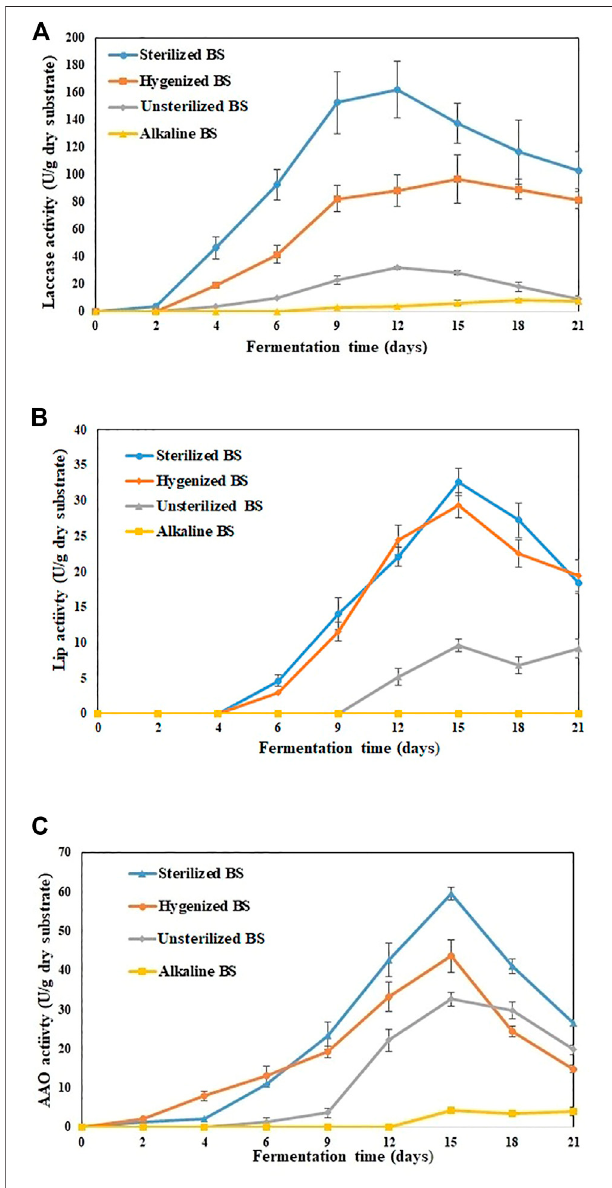
FIGURE 1 | Extracellular enzyme activities detected in various treated BS during 21 days of fermentation (A) laccase (B) Lignin peroxidase (C) Aryl alcohol oxidase. The experiments were done in triplicate at pH 7.0 and 30 ° C, and the error bar represents the standard deviations in each set of